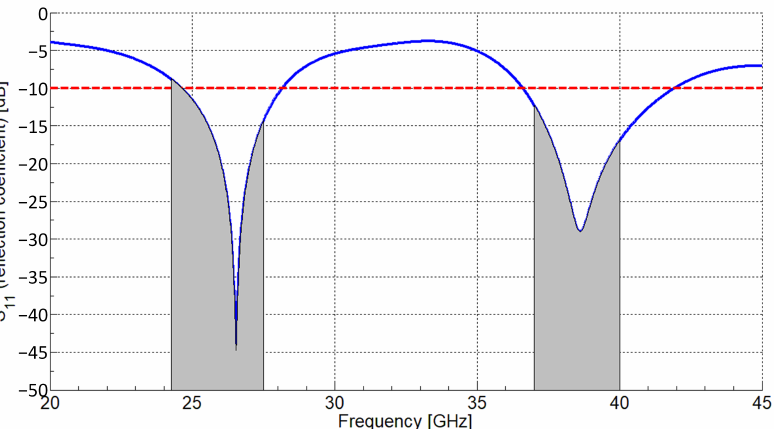
Figure 9. Reflection coefficient ( S 11 ) versus frequency of the best-obtained antenna design case (blue solid line: S 11 parameter, red dash line: − 10 dB limit, and gray shaded areas: n258 and n260 5G NR frequency